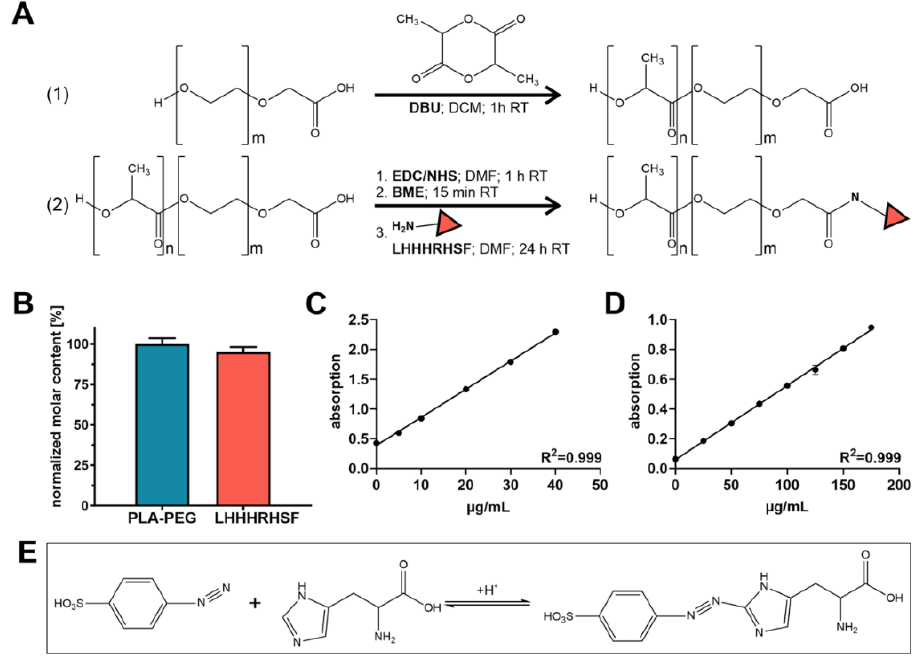
Figure 1. Polymer synthesis and characterization. ( A ) Exemplary synthesis procedure for peptide- modified PEG 5k -PLA 10k block co-polymer. (1) The PLA block was coupled via ring-opening polymerization of 3,6-dimethyl-1,4-dioxane-2,5-dione to hetero-bifunctional PEG polymer (m: PEG block of 5 kDa length; n : PLA block of 10 kDa length). (2) In a next step, COOH-PEG 5k -PLA 10k was